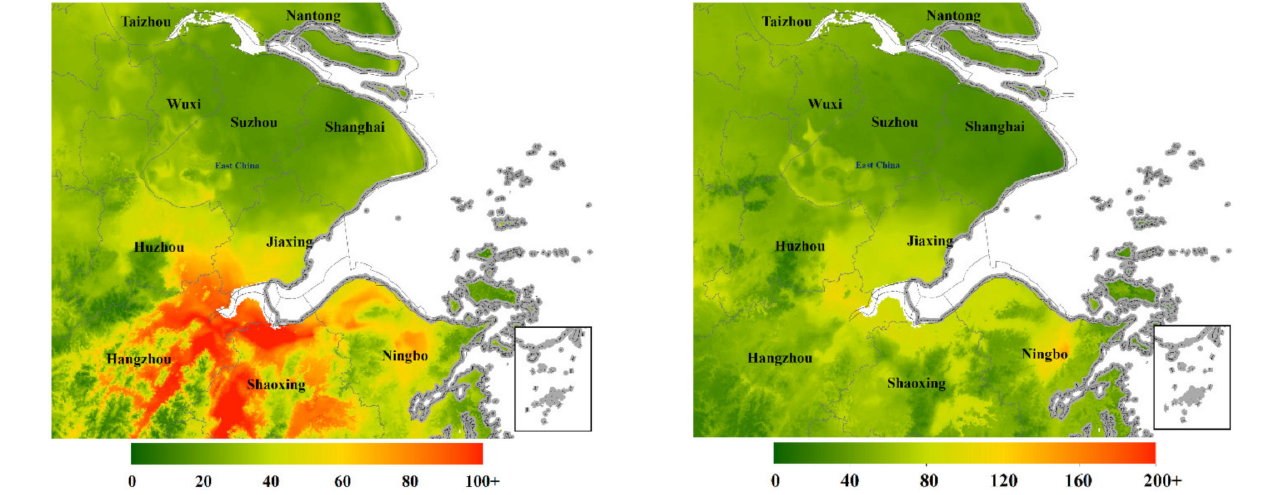
Figure 14. Predicted surfaces of PM 2.5 and PM 10 for four typical seasonal days in four typical regions (( a , b ) for the Jinjintang metropolitan area; ( c , d ) for the Urumqi city and its surroundings; ( e , f ) for Pearl River Delta; ( g , h ) for Yangtze River